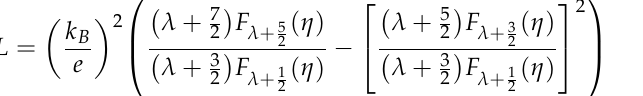
Figure 6. Temperature dependence of dimensionless figure of merit, ZT, for the bulk samples ob- tained by powder heat treatment at different temperatures and consolidation.